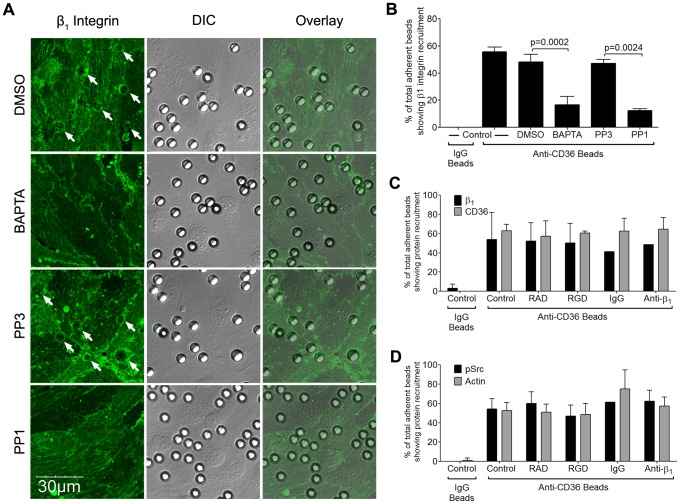
Inhibition of β1 integrin recruitment by Src family kinase inhibitor and intracellular Ca2+ chelator.(A) HDMEC monolayers were pre-incubated with PP3 or PP1 at a concentration of 10 µM for 2 hours, or DMSO or BAPTA for 30 min followed by HBSS for 30 min, at 37°C in 5% CO2. Anti-CD36 coated beads were then added to the monolayers for 30 min. After unattached beads were washed off, the monolayers were fixed and stained with Alexa 488-labeled anti-β1 integrin for 1 hr at room temperature. The images were taken as in Figure 7. Results shown are representative of 3 experiments. (B) Quantification of microscopic changes as described in Figure 7F. (C) HDMEC transduced with GFP-CD36 were either untreated, or pre-incubated with 20 µM RAD/RGD, or IgG1/inhibitory anti-β1 integrin mAb (clone TDM29) at 10 µg/ml for 30 min at 37°C in 5% CO2. After the addition of anti-CD36 coated beads for 30 min, the monolayers were fixed and stained as in (A). Quantification of 2 experiments is shown. (D) Anti-CD36 coated beads were added to peptide or antibody-treated HDMEC monolayers as in (C). The monolayers were fixed, permeabilized with 0.2%TX-100 for 5 min, and blocked with 1%BSA+0.003%TX-100 for 30 min. Monolayers were stained with a polyclonal anti-phospho-Src antibody overnight at 4°C followed by goat-anti-rabbit IgG-Alexa 488 for 1 hr at room temperature. The actin cytoskeleton was visualized by adding 1 µl of rhodamine-phalloidin in 60 µl HBSS to each chamber for 30 min at room temperature. Quantification of 2 experiments is shown.